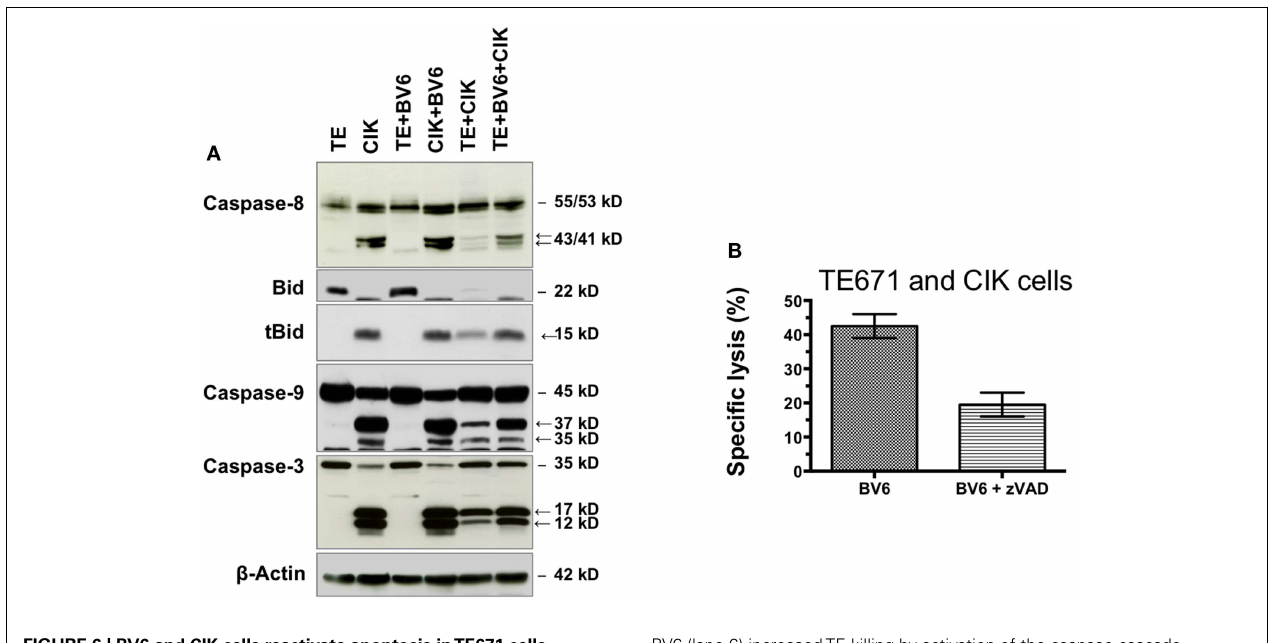
FIGURE 6 | BV6 and CIK cells reactivate apoptosis inTE671 cells . TE671 cells (TE) were treated for 4h with 2.5 µ M SMAC mimetic